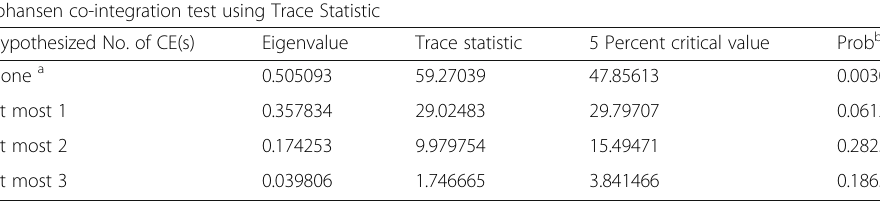
Table 2 Johansen co-integration test using trace statistic Johansen co-integration test using Trace Statistic Hypothesized No. of CE(s) Eigenvalue Trace statistic 5 Percent critical value Prob b None a 0.505093 59.27039 47.85613 0.0030 At most 1 0.357834 29.02483 29.79707 0.0612 At most 2 0.174253 At most 3 0.039806